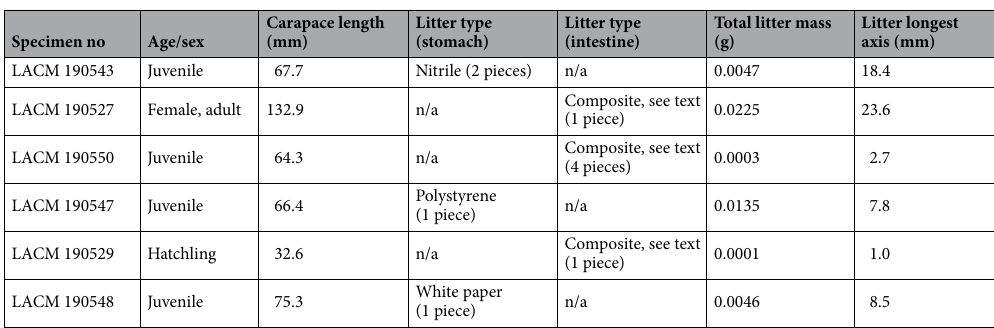
Table 1. Plastic and non-plastic human litter ingested by Red-eared Sliders, Trachemys scripta elegans , in the University of California Davis Arboretum,